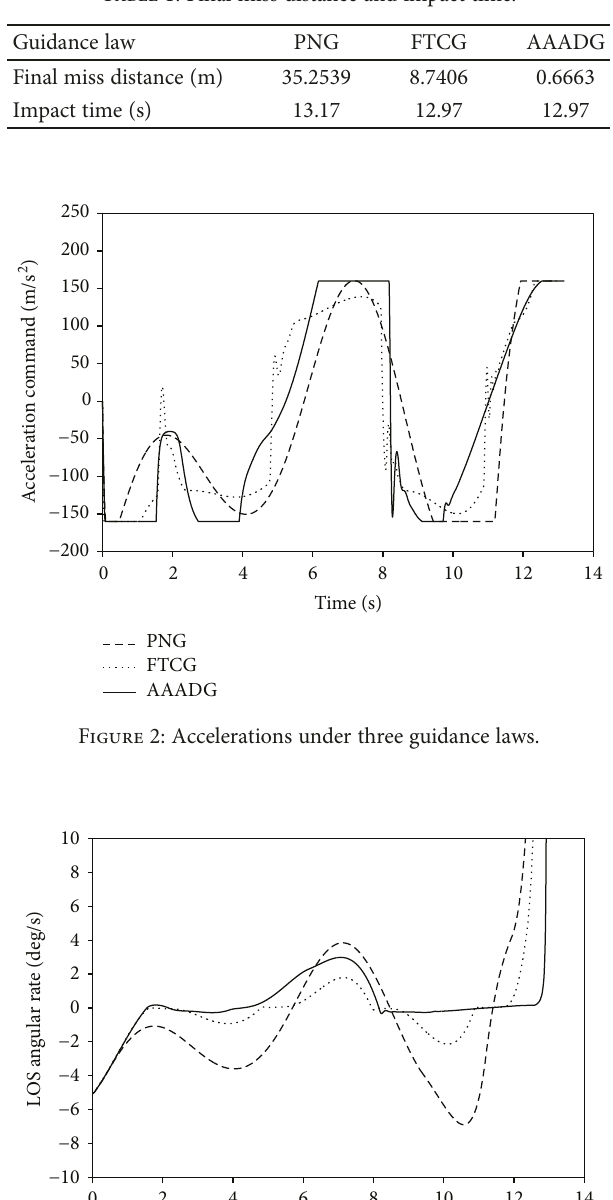
Table 1: Final miss distance and impact time.